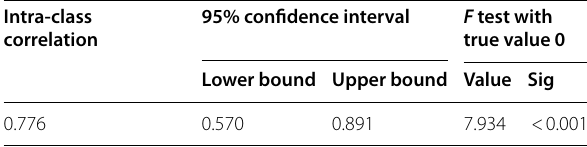
Table 6 Intra‑class correlation Intra-class correlation